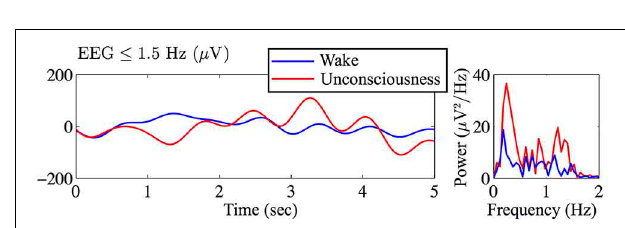
FIGURE 1 | Sample (A) wake (blue) and (B) sedated unconsciousness (red) EEG from archival Fp1 recording. Raw EEG data are filtered via AAR 2 to remove eye-blinkartifacts. AAR -correctedEEGaremarkedinblack.Thepowerspectrashowthatslow-waveoscillationsaredominantinthesedatedunconsciousnessstate.